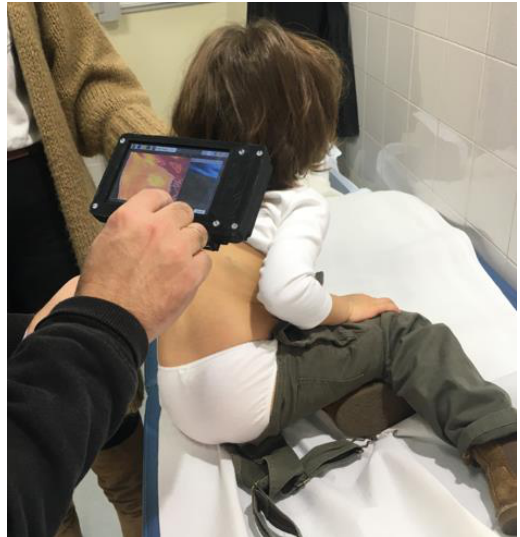
Figure 3. Illustration of how the system is used to study an IH. The IH is analyzed without touching the patient. The distance between the IH and the system is constant. On the screen, a real-time thermographic image is displayed. This photograph corresponds to a yearly control session for a previously treated IH patient who did not participate in the trial study.